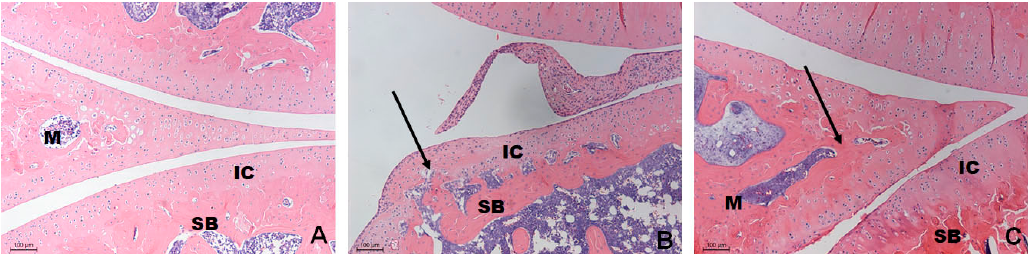
Figure 2- Descriptive analysis of the right posterior paw joints of animals from different groups: A) CTR, B) ART and C) ART/ASU. The arthritis induction promoted alterations in the cartilage articulation, since it was possible to note hyperplasia in the region associated with bone resorption in the subchondral area (black arrow), as observed in Figure B. In Figure C, it can be noticed that the ASU application partially prevented the articular alterations; however, it was still possible to notice changes in the morphology of the articular meniscus (Black Arrow) (Original augmentation 100x-HE). M, meniscus; IC, intra articular cartilage; SB, subchondral bone